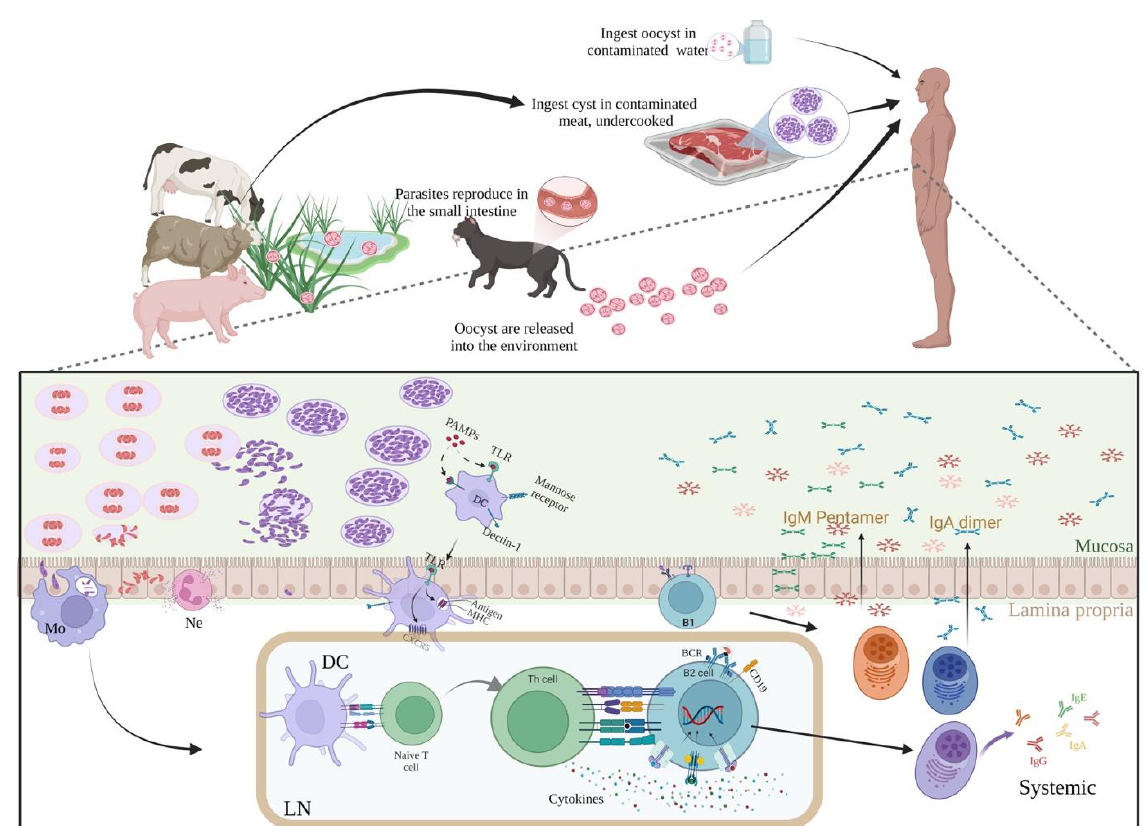
Figure 1. Immune response against Toxoplasma gondii . Both gestational and acquired toxoplasmosis occur by the ingestion of tissue cysts present in undercooked meat or oocysts that come from felines that release them with their feces; sometimes, water and legumes/pastures are contaminated. Thus, the parasite reaches the digestive tract. The sporozoite or bradyzoite released from the oocyst or tissue cyst, respectively, invades the enterocyte or crosses the epithelium to reach the submucosa, where there are gut-associated lymphoid tissues (GALT, such as Peyer’s patches) where a response begins: (a) Local macrophages (Mo) phagocytize the parasite and initiate an inflammatory response, together with local granulocytes (neutrophils, Ne); (b) B-1 cells can produce IgM and IgG antibodies (and IgA) after antigen or Pathogen-associated Molecular Patterns (PAMPs) recognition through the B cell Receptor (BCR), the Pattern Recognition Receptors (PRRs)- mainly Toll-Like Receptors (TLRs)- or both; B-1 and some marginal zone B cells (MZB) are able to spontaneously produce “natural” antibodies to microbiota, pathogens or autoantigens, that may cross-react with T. gondii ; (c) Dendritic cells (DCs) take up antigens and travel to the nearest lymph node (LN) guided by chemokines recognized by specific receptors (such as CXCR5); at the LN, they stimulate both T helper lymphocytes (Th-CD4+), which convert into Th1 and produce Interferon-gamma (IFN- γ ) and other cytokines, and cytotoxic T cells (CTL, CD8+), which become important for infected cell destruction; (d) The antigen also reaches the LN where the B-2 (follicular) B cells are primed and become available for CD4+ T help, undergoing antibody class switch. After selection of highly specific clones by DCs, they become plasma cells (PCs), which migrate to the bone marrow (BM) and secrete IgG, IgA or IgE antibodies. B-2, CD4+ and CD8+ memory cells are also born in the LN and migrate to different tissues, where they react more rapidly to a second stimulus. Protective mechanisms include complement fixation, opsonized phagocytosis, infected cell cytotoxicity by IFN- γ activated NKs and CTLs. This response is modulated by regulatory T lymphocytes and other cell types, including B-1 (B10) and M2 macrophages, directly or through tumor growth factor beta (TGF- β ) or Interleukin (IL)-10. This summary is oversimplified to direct attention to antibody production. Please refer to relevant reviews of this topic for further details and other cell types and molecules involved [6–12]. Graphical contents were created with BioRender.com (license MX249HDDR2, accessed on 9 August